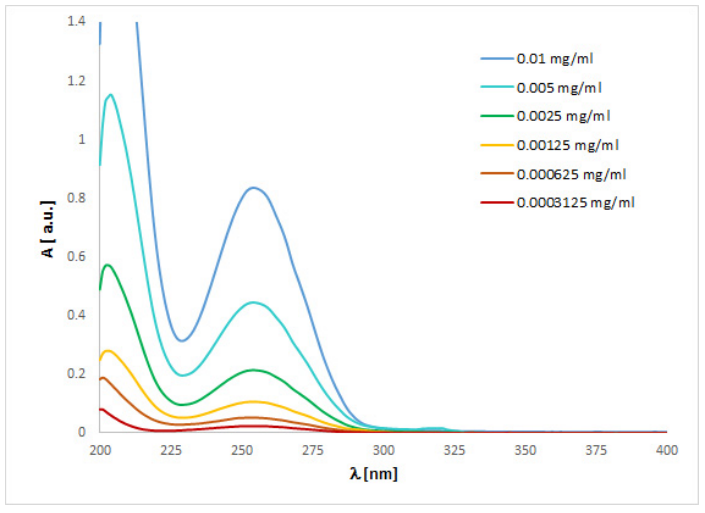
Figure 5. Experimental UV-vis spectrum of bifonazole 2 registered in methanol at various concen- trations.